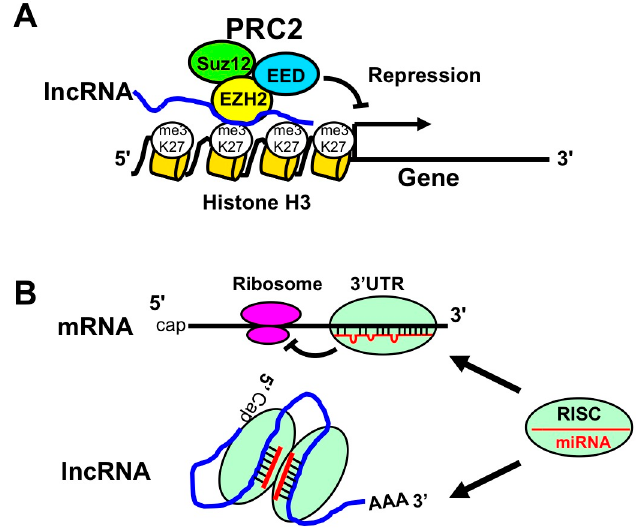
Figure 4. The role of long non-coding RNAs (lncRNAs). ( A ) LncRNA-PRC2 complex suppresses gene transcription. LncRNA binds to polycomb proteins, such as EZH2, EED, and Suz12. These